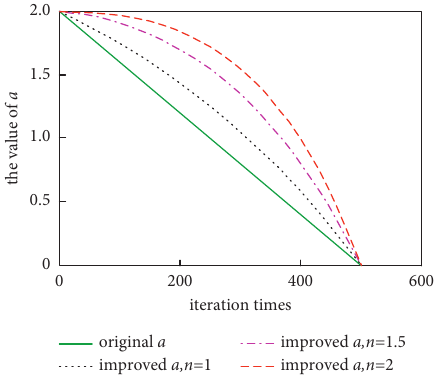
Figure 3: Comparison of the control parameter a .